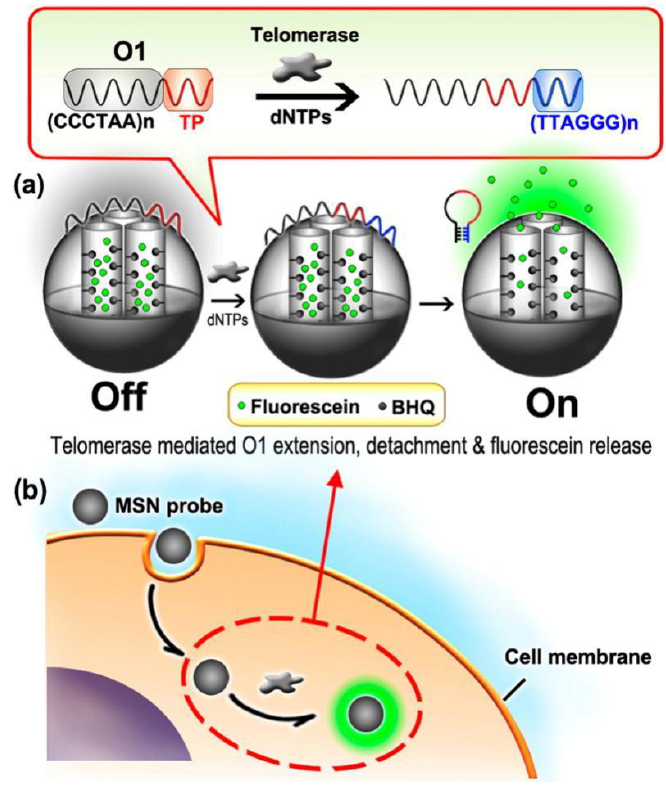
Figure 10. Schematic illustration of MSN probe-based intracellular detection of telomerase. Reproduced with permission from [76]. Copyright 2013 American Chemical Society. BHQ, black hole fluorescence quencher.